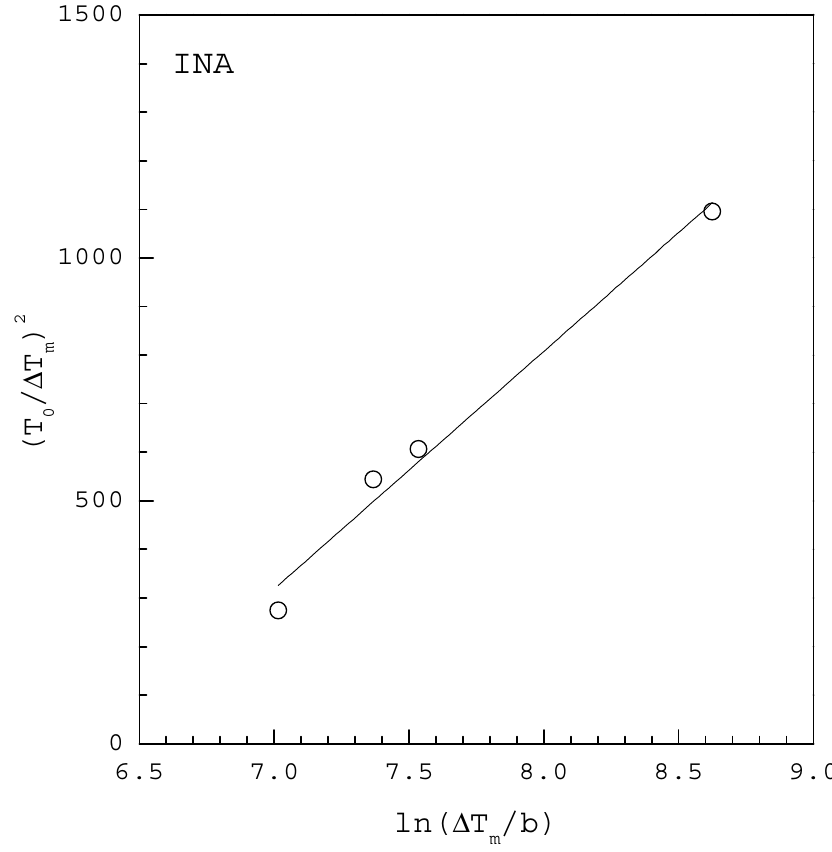
Figure 2. The MSZW data fitted to the linearized Equation (11) for INA in 1 mL ethanol saturated at T 0 = 307.76 K, where ∆ T m for each b is extracted at 50% of fraction detected nucleation events from the cumulative distributions of the MSZW data obtained by Kulkarni et al.